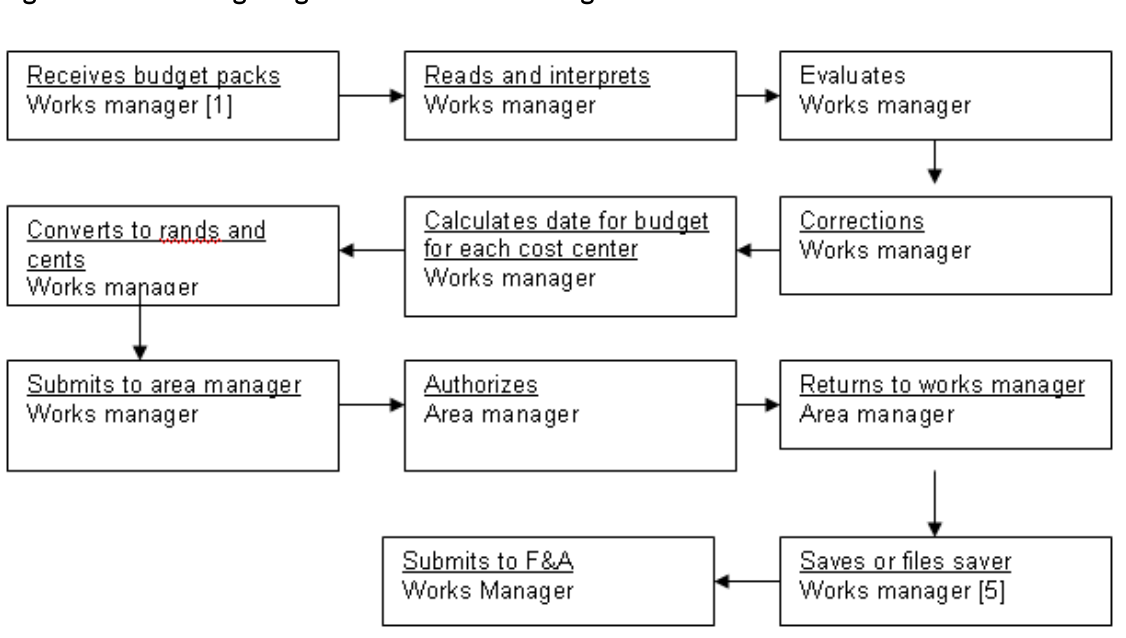
Figure 2 Plant budgeting after the CPM